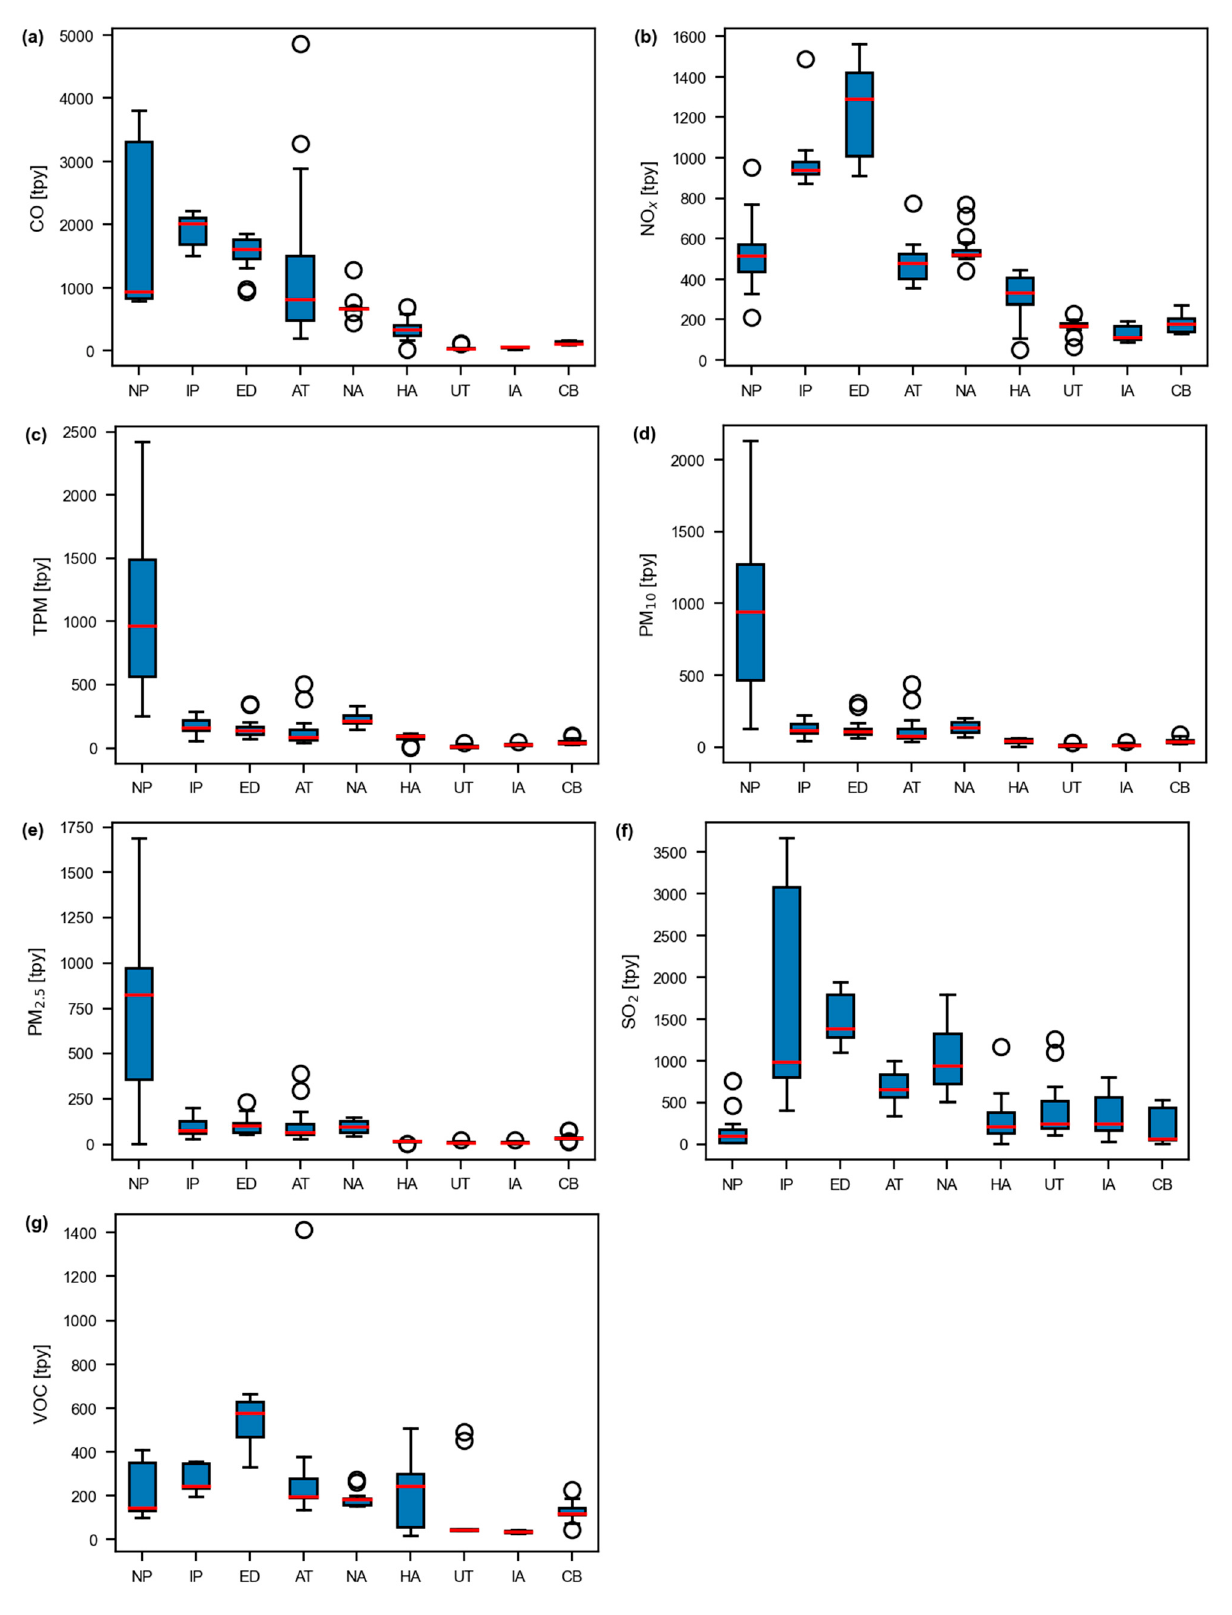
Figure 4. Distribution of air pollutant emissions from 2002 to 2019 for each facility for the pollutants